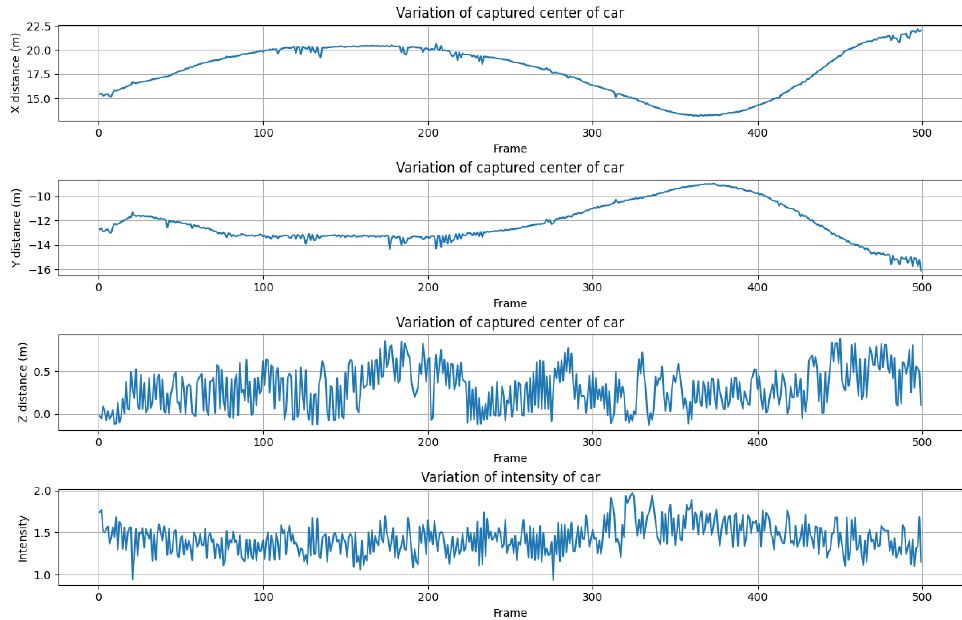
Figure 7. Example of vibration test result. We observed the position and the intensity of the front car being driven at a constant speed (30 km/h) on a country